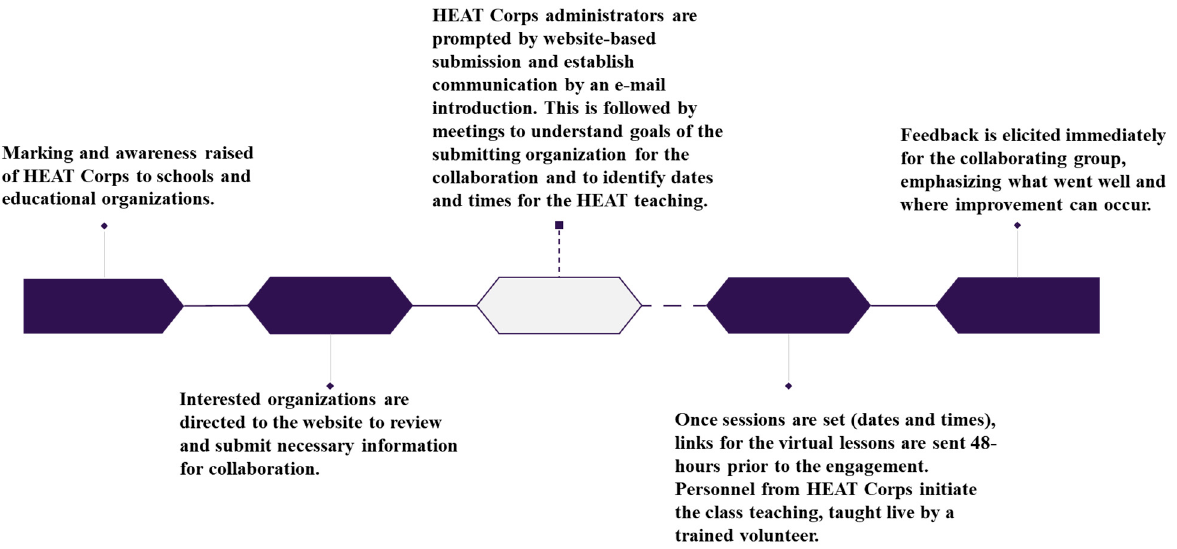
Figure 1. Summary of steps for accessing HEAT Corp information to establish a collaboration with a school and/or educational organization.